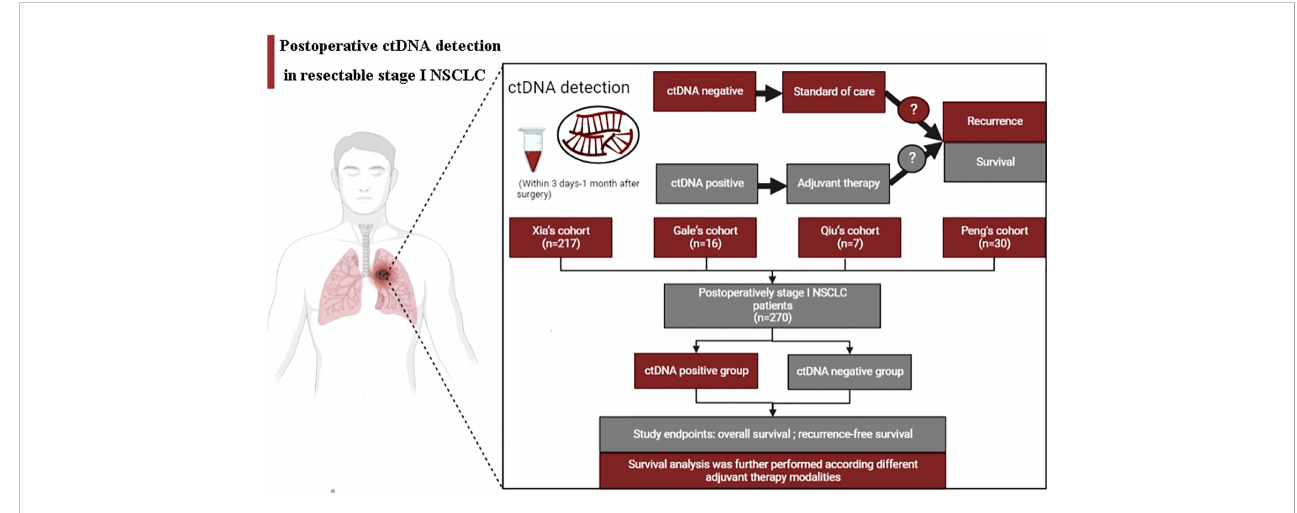
FIGURE 1 Schematic illustration of working hypotheses and work fl